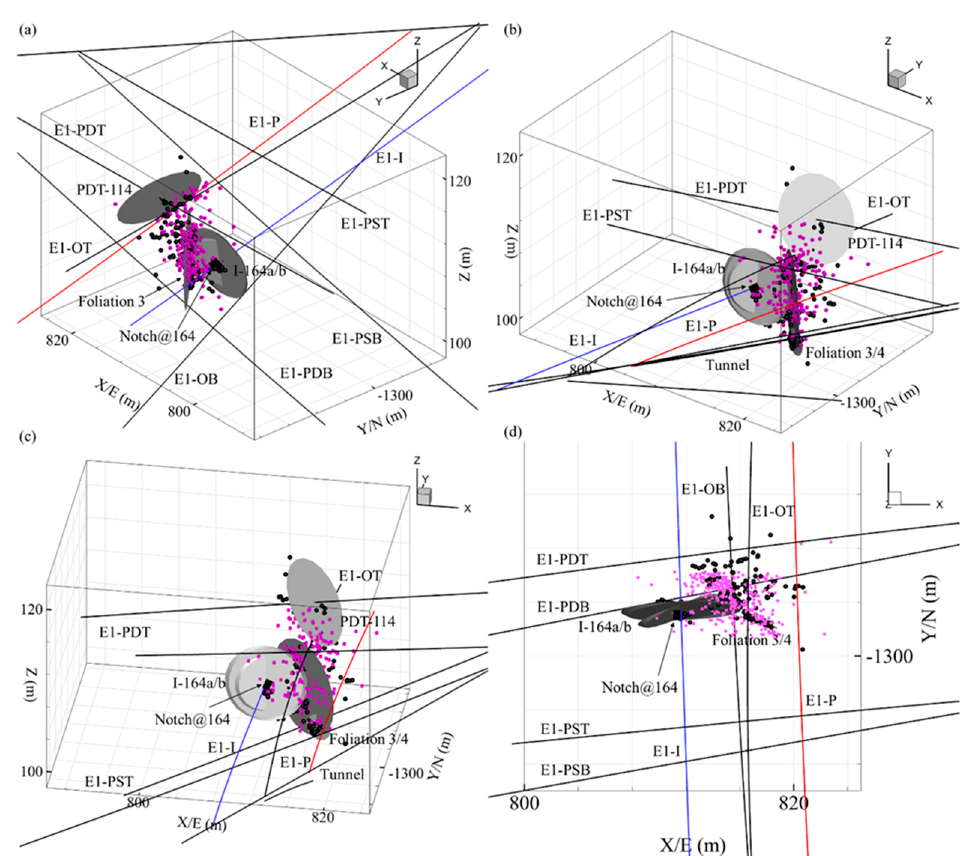
Figure 19. Distribution of seismicity and location of four major foliation planes estimated from field observation (e.g., seismicity and ERT). Black spheres represent the field-observed seismicity. Pink cubes represent the simulated seismicity. Foliation planes 3 and 4, I-164-a/b and PDT-114 have slipped. The simulated seismicity generally matches the field-observed seismicity. Different figures ( a – d ) show different views.